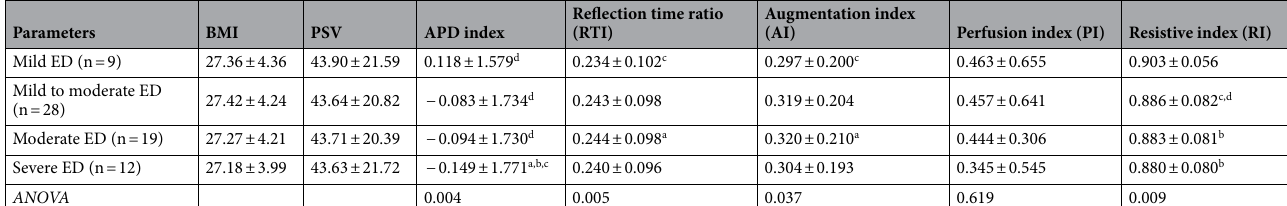
Table 2. The comparison of BMI, PSV, APD, and penile waveform series in ED severity. BMI Body mass index, PSV Peak systolic velocity of cavernous artery. a Post-hoc test p < 0.05 compared with mild ED. b Post-hoc test p < 0.05 compared with mild to moderate ED. c Post-hoc test p < 0.05 compared with moderate ED. d